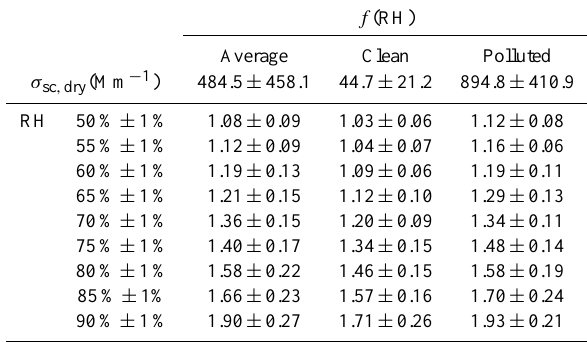
Table 1. The measured f (RH) at given RHs, along with the simul- taneously measured 5min mean dry σ sc , under different pollution levels (mean value ± standard deviation (1 σ)) . “Average” here rep- resents the overall mean value for the whole f (RH) measurement